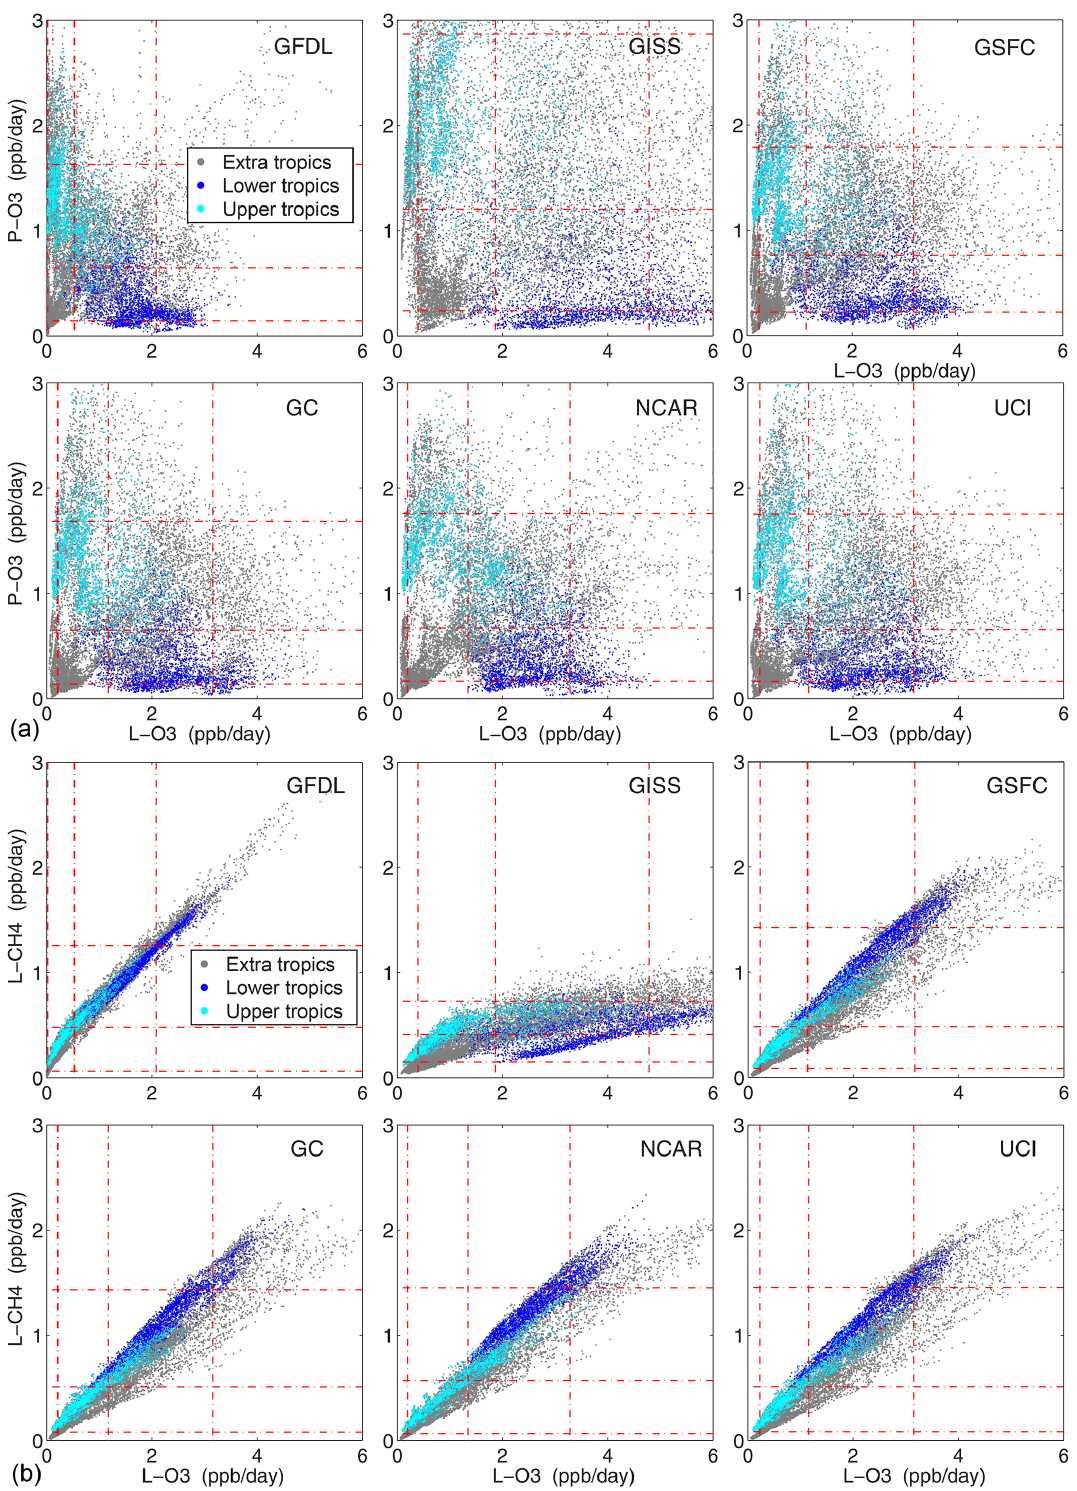
Figure 2. Parcel reactivities of (a) P -O3 and (b) L -CH4 vs. L -O3 for each of the models. Points are colored by location: 60–20 ◦ S and 20–60 ◦ N (extra tropics, gray); tropics (20 ◦ S–20 ◦ N) upper ( p <600hPa, cyan) and lower ( p >600hPa, blue). The 10th, 50th, and 90th percentiles in each dimension are plotted as red dash-dot